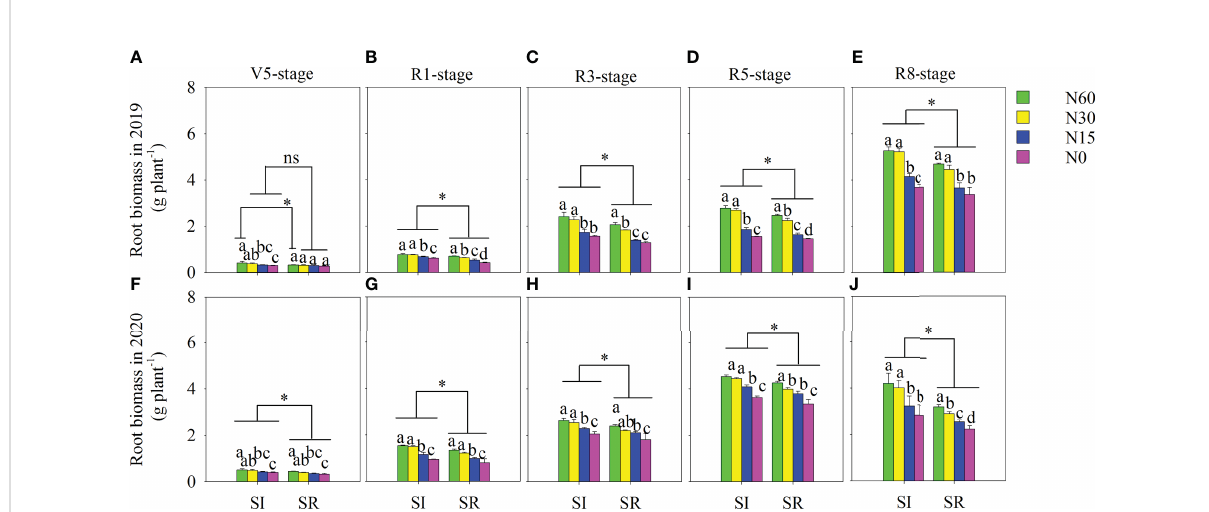
FIGURE 2 Effects of straw incorporation and nitrogen application on root biomass of intercropped soybean at the different growth stages. Different lower- case letters indicate signi fi cant differences under different N application rates ( LSD , P < 0.05). Data were shown as mean ± S.D. (n=3). The asterisk “ * ” and “ ns ” indicate signi fi cant differences ( P < 0.05) and insigni fi cant differences ( P >0.05) between straw incorporation and straw removal, respectively. SI, straw incorporation; SR, straw removal; N60, convention N (60 kg N ha -1 ); N30, reduced N by 50% (30 kg N ha -1 ); N15, reduced N by 75% (15 kg N ha -1 ); N0, zero N (0 kg N ha -1 ); V5, the fi fth trifoliolate stage of soybean; R1, the beginning fl owering stage of soybean; R3, the beginning pod stage of soybean; R5, the beginning seed stage of soybean; R8, the full-maturity stage of soybean. (A) , root biomass at the V5 stage in 2019; (B) , root biomass at the R1 stage in 2019; (C) , root biomass at the R3 stage in 2019; (D) , root biomass at the R5 stage in 2019; (E) , root biomass at the R8 stage in 2019; (F) , root biomass at the V5 stage in 2020; (G) , root biomass at the R1 stage in 2020; (H) , root biomass at the R3 stage in 2020; (I) , root biomass at the R5 stage in 2020; (J) , root biomass at the R8 stage in